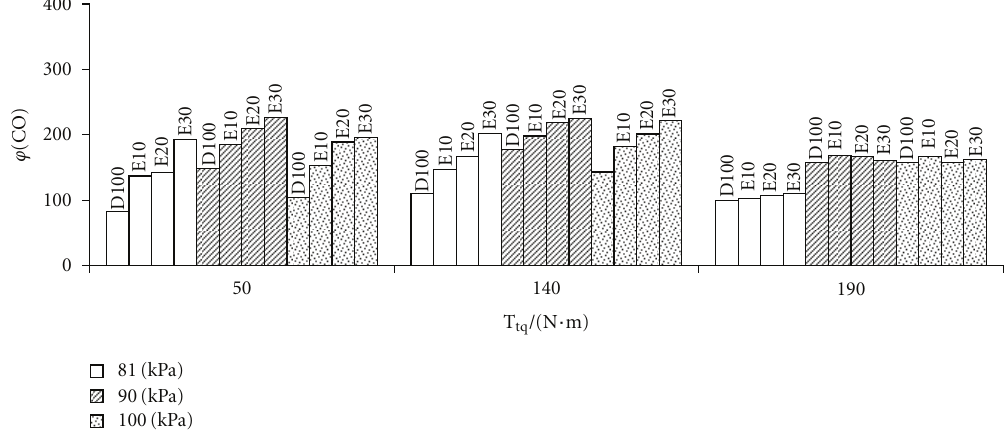
Figure 4: Comparison of HC emission of di ff erent atmospheric pressure and mix proportion at speed 3200 r/min.